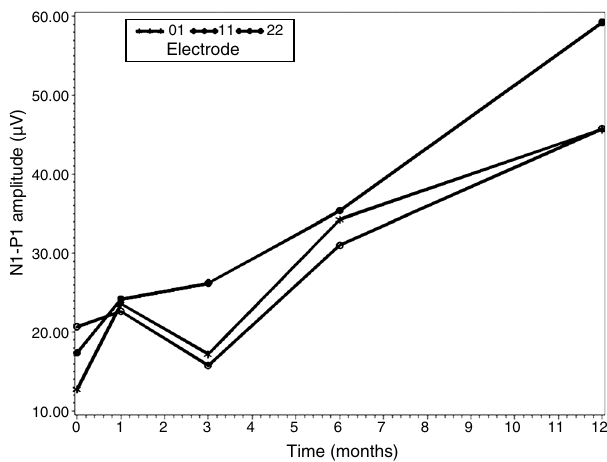
Figure 4 Mean value of N1-P1 wave amplitude ( (cid:2) V) in the third month of follow-up between E11 and